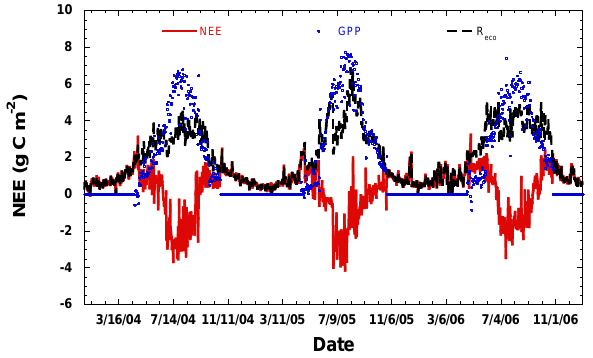
Fig. 11. Cumulative gross primary production ( GPP ), net ecosystem exchange ( NEE ), and ecosystem respiration ( R eco ) over the three seasons.